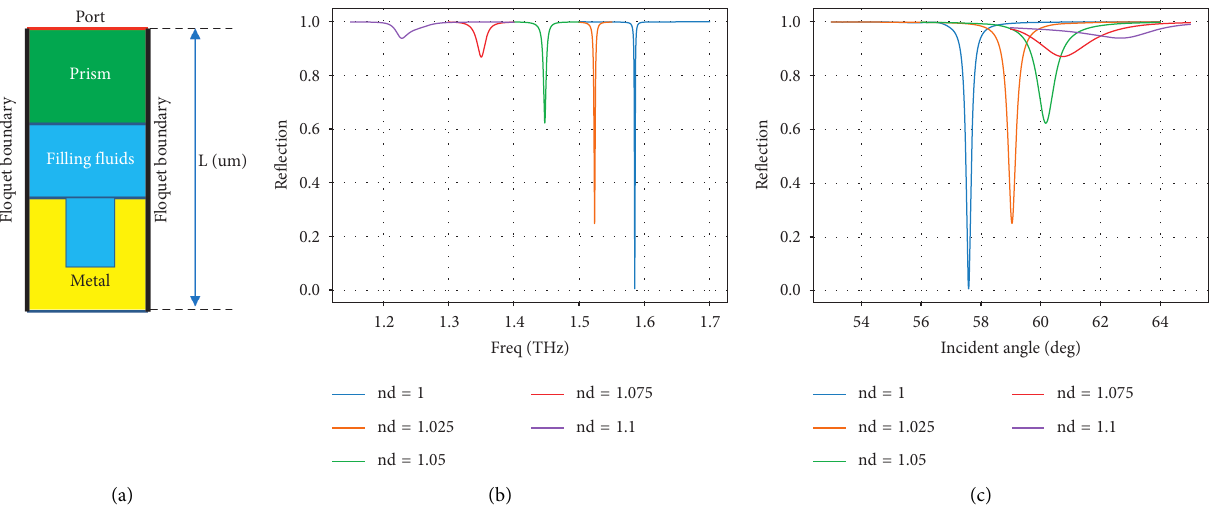
Figure 3: The unit cell structure (a) of 1D periodic groove and the reflectivity spectrums as a function of resonance frequency (b) and resonance angle (c) for the fluids filled with different refractive